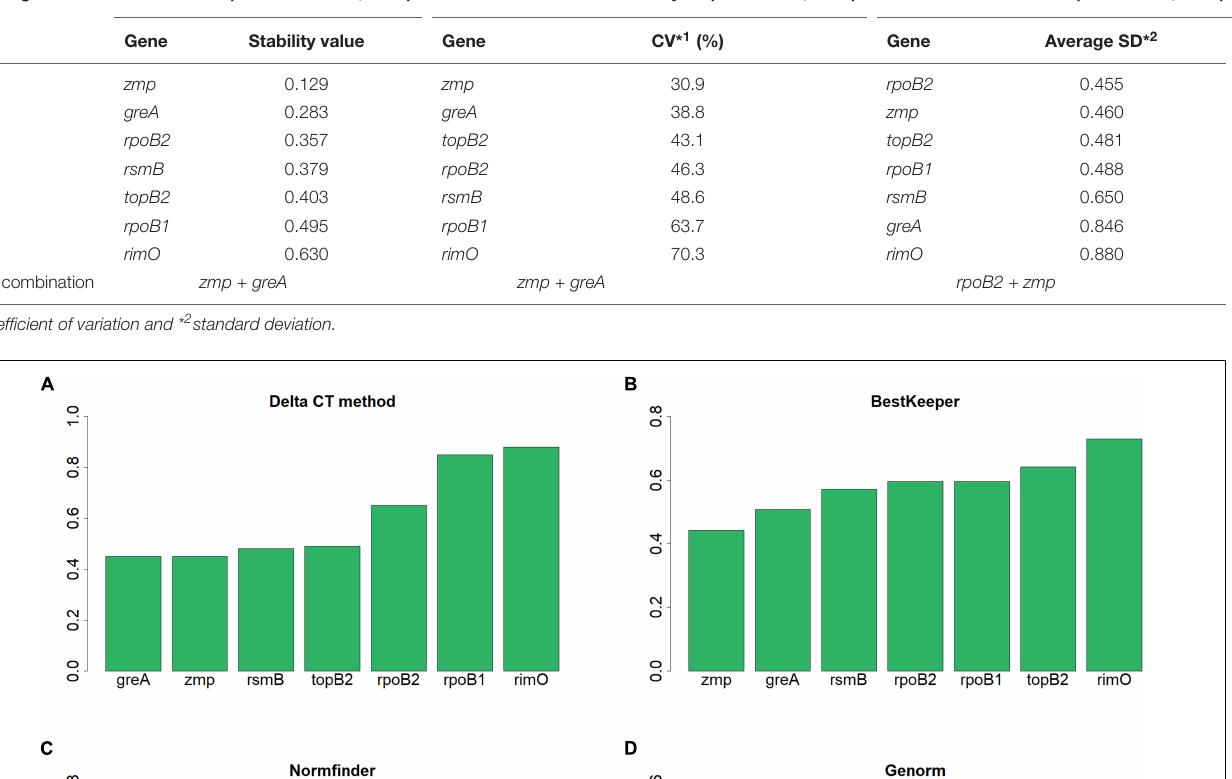
TABLE 7 | Expression stability of candidate reference genes in C. beijerinckii NRRL B-598 assessed by different analytical tools. Ranking NormFinder (Andersen et al., 2004) Coefficient of variation analysis (Boda et al., 2009) Pairwise (cid:49) Ct method (Silver et al., 2006)